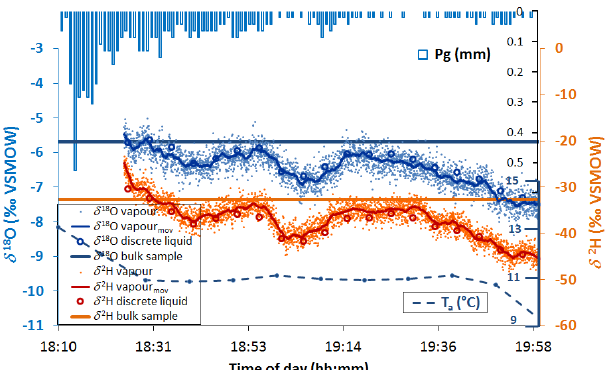
Figure 2. Time series of rainfall (P g ) depth per minute (vertical bars): 10min data of air temperature in 250m distance ( T a ) (dashed line) during the rainfall event from 17 April 2015; data of δ 18 O in blue and δ 2 H in orange; vapour-derived data recorded every 2s (small dots), starting after temperature at the contactor was stable, 90s moving average (vapour mov ) (solid lines), discrete liquid sam- ples (open circles) taken every 5min, and event-based bulk sample (horizontal bars).